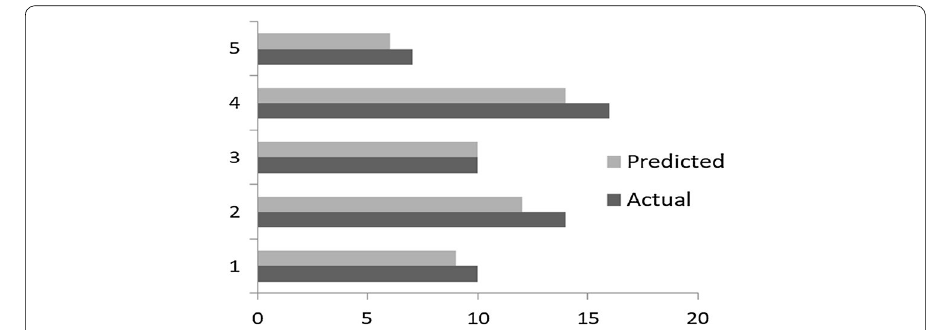
Fig. 3 Actual values of G3 compared to predicted values